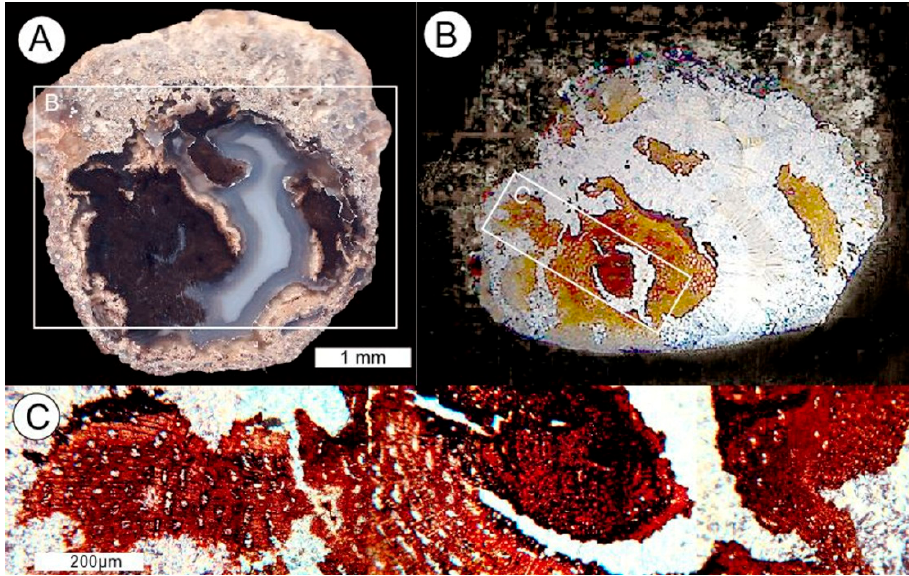
Figure 12. Fossil wood showing evidence of extensive decay prior to mineralization. ( A ) Transverse view showing silicified stromatolite coating, and a large chalcedony-filled fracture. ( B ) Transverse thin section, showing extensive chalcedony enclosing wood fragments. ( C ) Higher magnification shows the degradation of wood prior to fossilization.